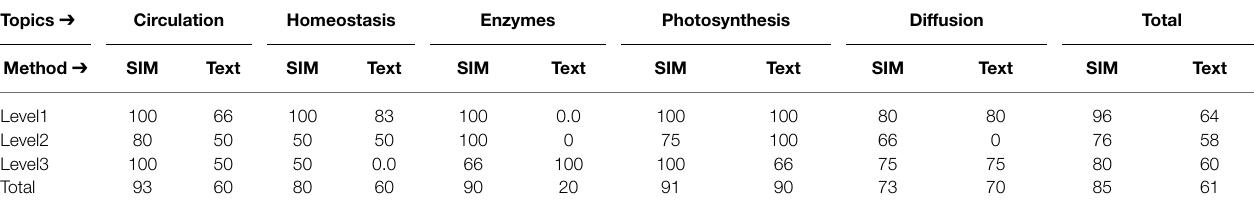
TABLE 9 | Comparing 9th grade biology classes using SIM-based generative practices vs text-based illustration practices.